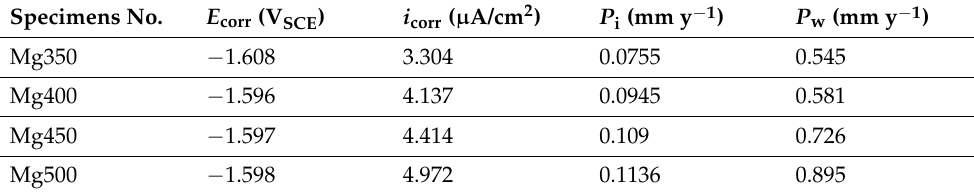
Table 1. The polarisation data of of the different annealed conditions in Hank’s solution.